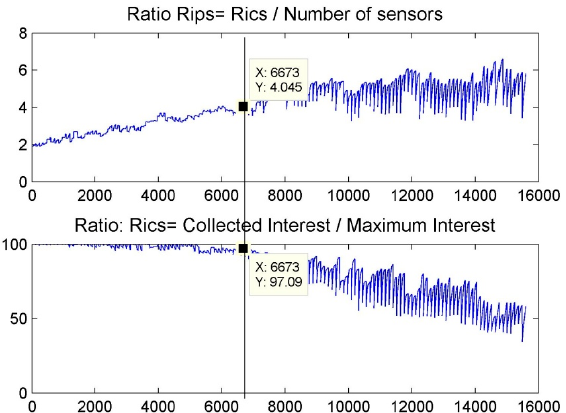
Figure 15. Ratio Rips & Ratio Rics “Scenario 1”.